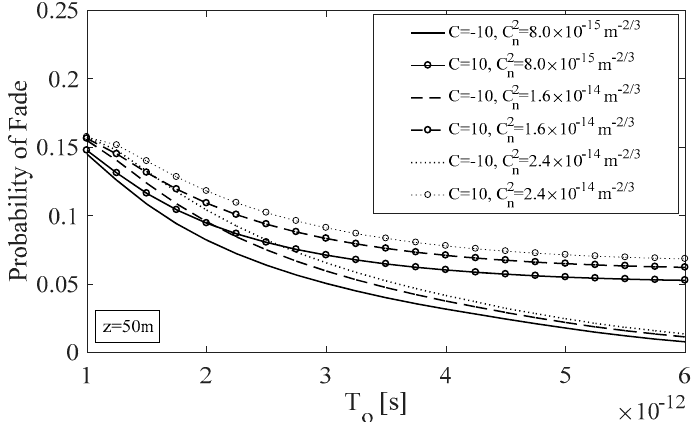
Figure 4. Probability of fade for a UOWC system under the joint action of GVD, time jitter and fluid turbulence effect, as a function of the longitudinal pulsewidth of the Gaussian pulse for a 50-m horizontal propagation distance and 100-m depth.